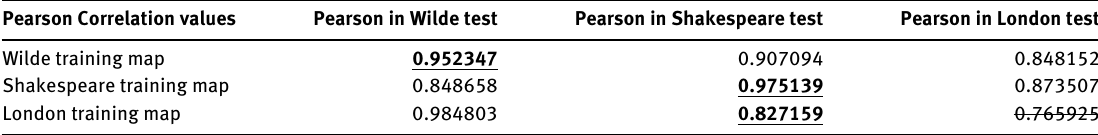
Table 3: Prediction Results Showing Authors’ Training Map vs. Authors’ Test Books for the Previous Test [11]. Pearson Correlation values